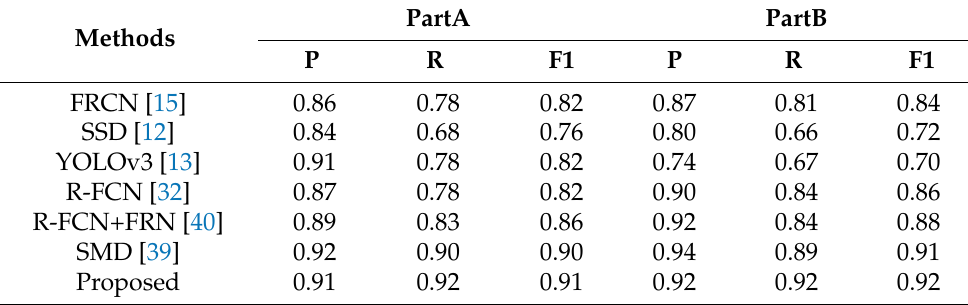
Table 8. Results of our method compared with other methods on the SCUT-HEAD